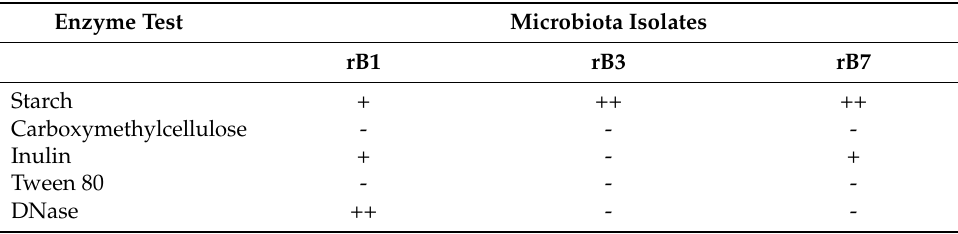
Table 3. Enzymatic activity in gut microbiota isolates.